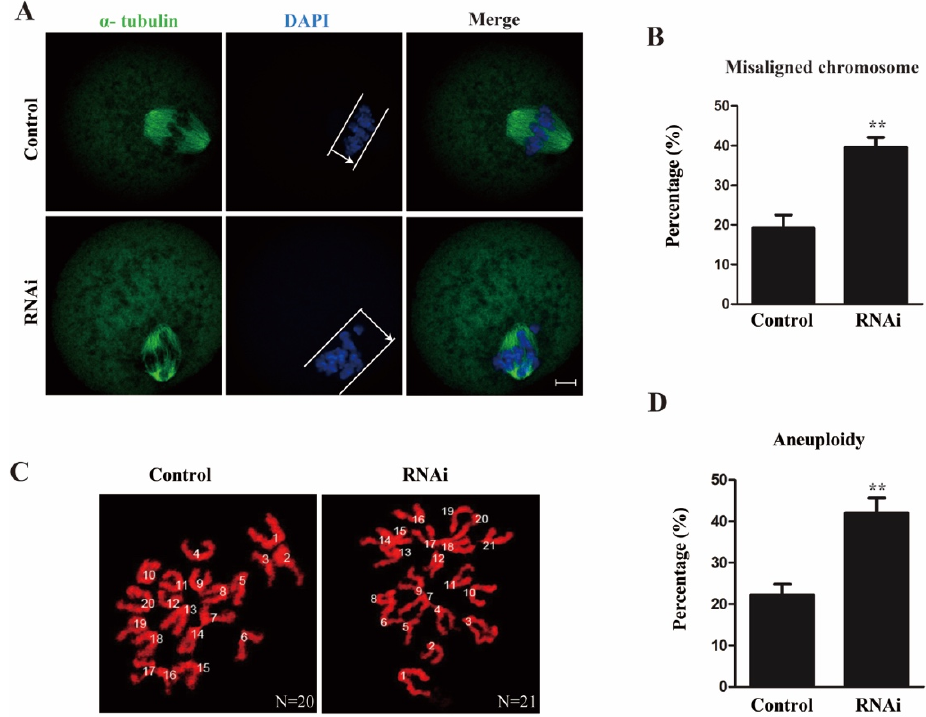
Figure 3. Rae1 knockdown induces abnormal chromosome alignment and elevated aneuploid rate in oocytes. ( A ) Representative confocal images of spindle morphology and chromosome alignment in the control and Rae1 knockdown MI oocytes. The white line and arrow indicate that in the control group, chromosomes are congressed and aligned at the spindle midzone, while in the Rae1-knockdown groups, chromosomes are scattered and dispersed. α -tubulin is shown in green and DAPI is shown in blue. Scale bar = 10 µ m. ( B ) The rate of misaligned chromosomes is recorded and compared in the control ( n = 96) and Rae1 knockdown MI oocytes ( n = 108). ** p < 0.01 ( C ) Representative confocal image of chromosome spread at the MII stage in the control and Rae1 knockdown group. Control oocytes with a normal haploid complement of 20 chromosomes and Rae1 knockdown oocyte with 21 chromosomes. Chromosomes were stained with propidium iodide (PI) and is shown in red. Scale bar = 5 µ m. ( D ) The aneuploidy rate is recorded and compared in the control ( n = 31) and Rae1 knockdown oocytes ( n = 35). ** p < 0.01. The data are presented as mean ± SEM of at least three independent experiments.